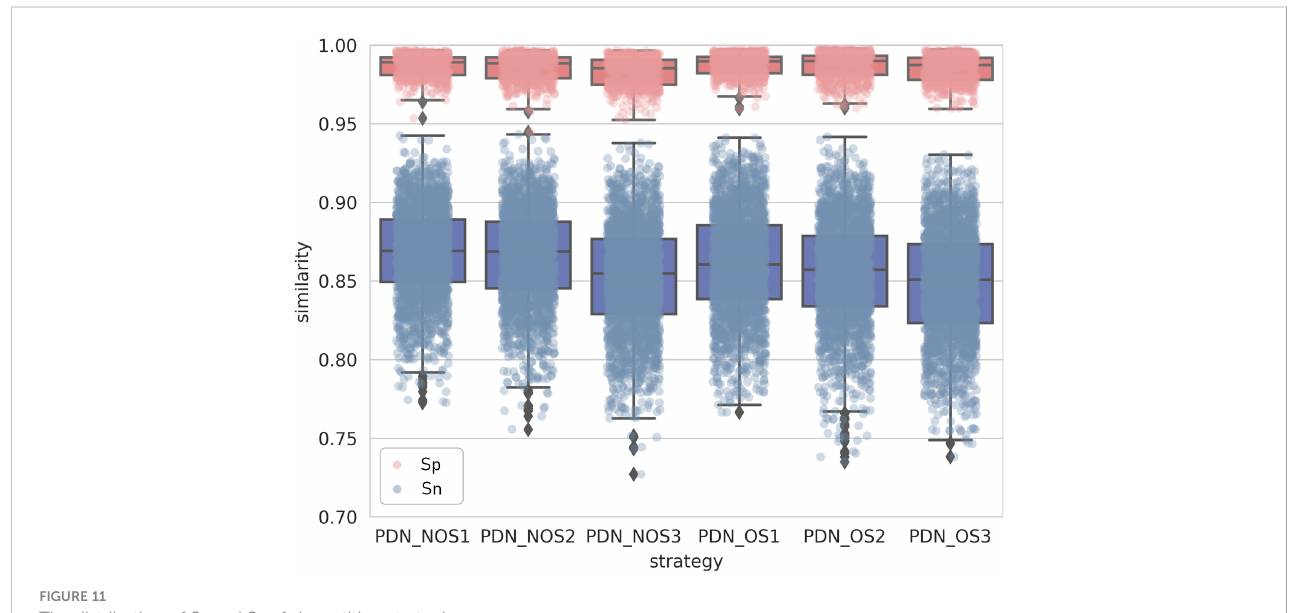
FIGURE 11 The distribution of S p and S n of six partition